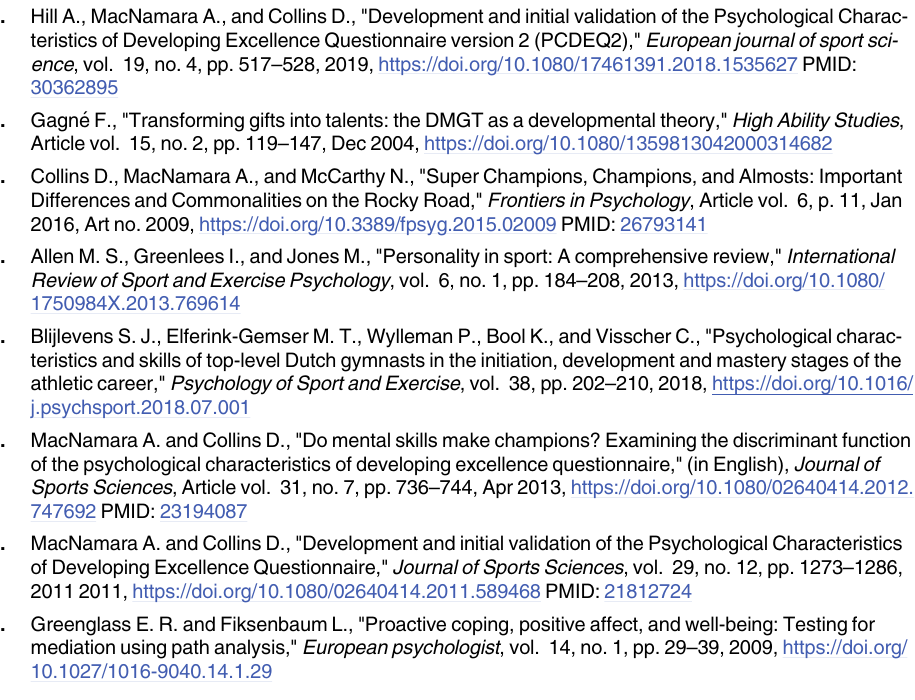
S2 Table. Items per factor of the PCDEQ-C. S3 Table. Comparison of the PCDE factors for the PCDEQ-C and